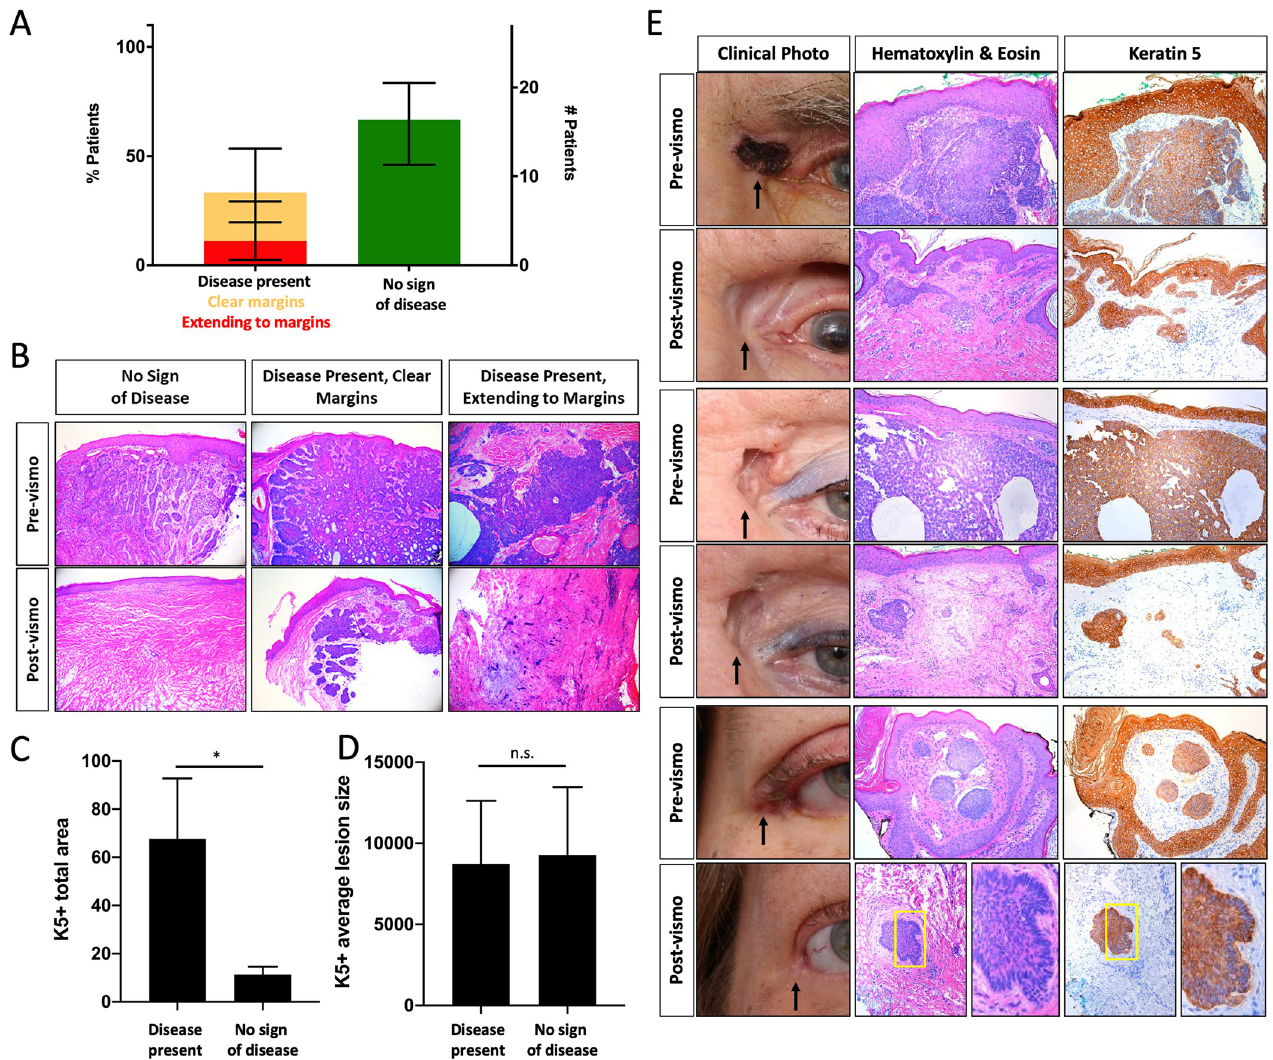
Fig 1. Keratin positive micro-tumors present despite complete clinical response to vismodegib. A) Pathology results for excision samples after vismodegib treatment (error bars indicate 95% CI, n = 9 (left column), n = 18 (right column)), B) Pre- and post-vismodegib histology, C) Average total area and D) Average lesion size (pixels) of keratin 5 positive staining (normalized to section length, error bars indicate SEM, unpaired t-test � p < 0.05, n = 7 (left column), n = 11 (right column)), E) Clinical photo, histology, and keratin staining pre and post-vismodegib treatment of patients scored as “no sign of disease” (black arrow–tumor location, yellow box—area of peripheral palisading).